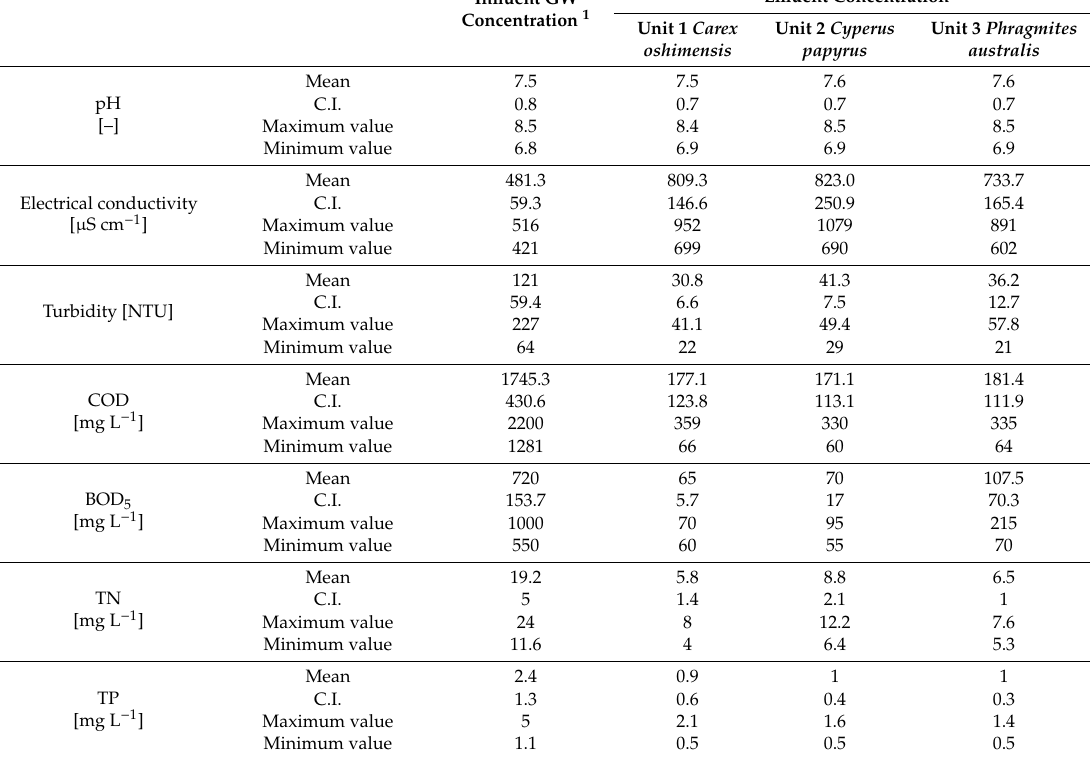
Table 1. Overall statistics of influent greywater (GW) and e ffl uent concentrations in each